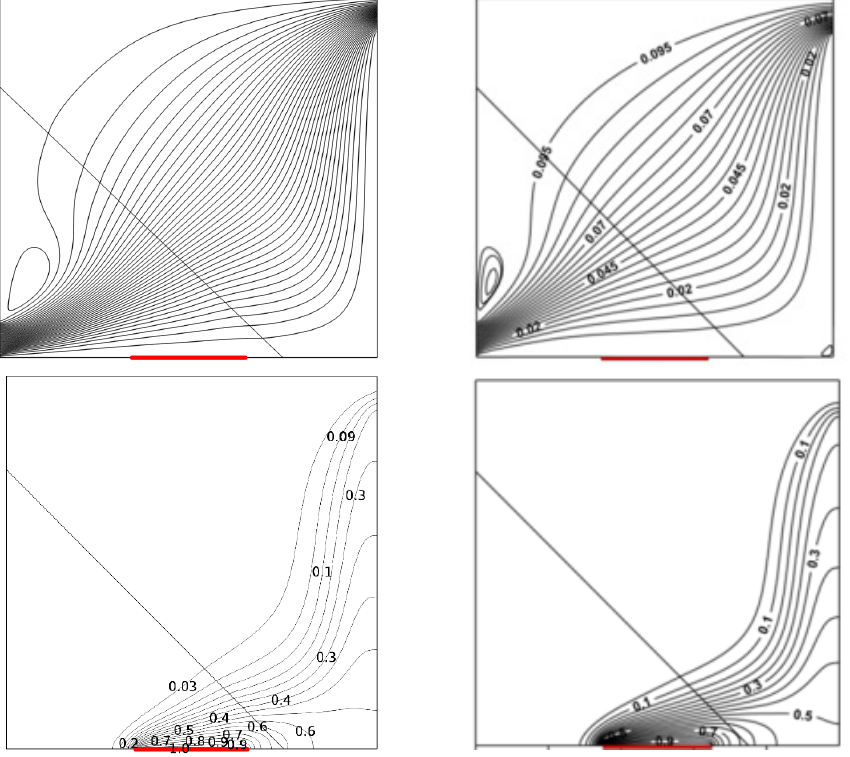
Figure 3. Comparison of the flow structure and temperature field with those of Gibanov et al. [39]. Reprinted with permission from ref. [39]. Copyright 2017 Springer Nature.